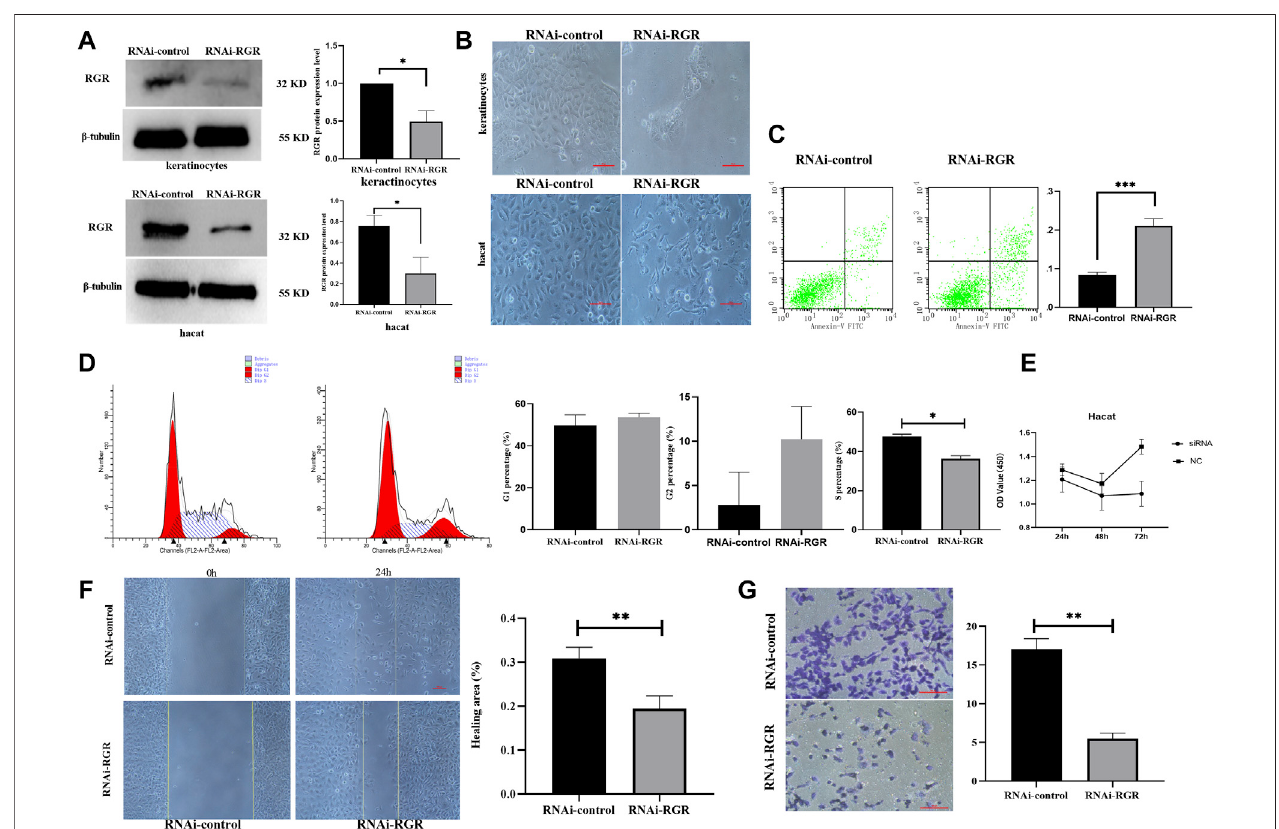
FIGURE 5 | RGR regulates the proliferation, migration, and apoptosis of keratinocytes. (A) Representative keratinocyte defects in RGR (with small siRNA) and β - tubulin (loading control) were detected by WB analysis. The relative protein levels of RGR and β -tubulin were measured using ImageJ software (n = 3 independent experiments). * p < 0.05, ** p < 0.01, *** p < 0.001. (B) Representative images of cell fragmentation and cell contraction observed under a light microscope in the si-RGR transfection group. No signi fi cant morphological change was detected in the si-control group. Scale bar = 20 μ m * p < 0.05, ** p < 0.01, *** p < 0.001 vs the control group. (C) FlowcytometrywithannexinVFITC/PIdoublestainingwasusedtodetermineapoptoticcells.FollowingRGRknockdown,asigni fi cantdecreaseinapoptosis was detected in the keratinocytes transfected with si-RGR compared with the control. * p < 0.05, ** p < 0.01, *** p < 0.001 vs the control group. (D) Flow cytometry was used to detect the cell cycle after RGR knockdown in keratinocytes. Following RGR knockdown, a signi fi cant decrease in the S phase at 48 h was detected in keratinocytestransfectedwithsi-RGRcomparedwiththecontrol.* p < 0.05vsthecontrolgroup. (E) RGRinkeratinocyteswasinhibited via Si-RGR,andcellviabilitywas measured after 48 h. (F) Representative images from wound healing experiments showed low expression of the RGR and decreased mobility relative to controls. Scale bar=50 μ m* p < 0.05,** p < 0.01,*** p < 0.001vsthecontrolgroup. (G) TranswellassaysshowedthatknockingdownRGRreducedtheinvasionbykeratinocytes.Scale bars = 50 μ